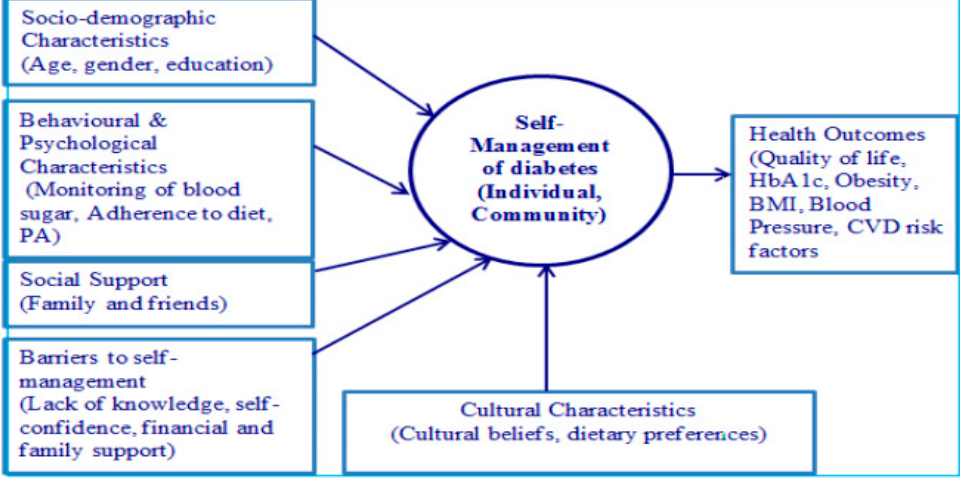
Figure 1. Conceptual model of self-management of type 2 diabetes [28].